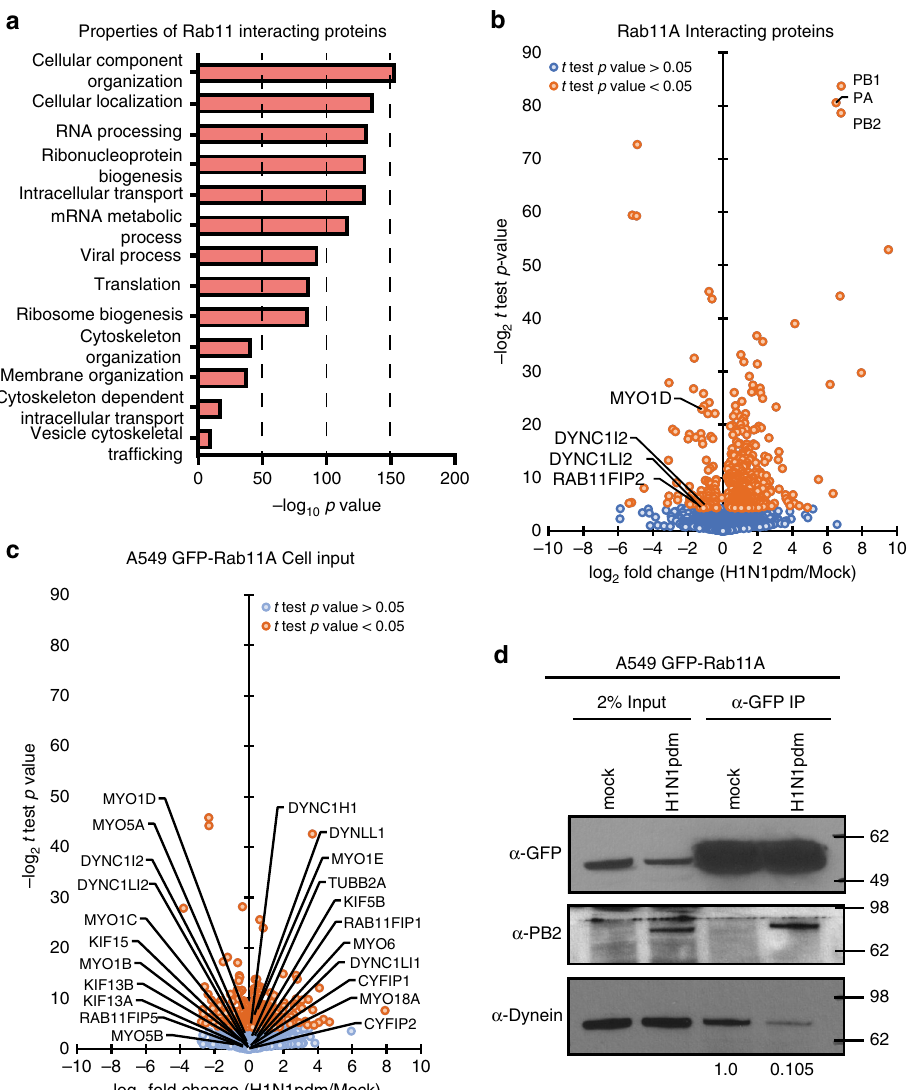
Fig. 7 Rab11A association with dynein motors is decreased during IAV infection. Mass spectrometry of immunoprecipitation (IP) input or α -GFP IP from A549 GFP-Rab11A cells either uninfected or infected with H1N1pdm. a Gene Ontology analysis of Rab11A-interacting cellular proteins revealed by immunoprecipitation – mass spectrometry. b Change in Rab11A-interacting proteins as a ratio of infected to mock cells. Vesicle transport-related proteins signi fi cantly altered during infection and viral polymerase proteins are highlighted. c Ratio of host proteins in IP input as a ratio of infected to mock cells. d Validation and quanti fi cation of dynein levels bound to Rab11A in mock or H1N1pdm-infected cells. Relative band intensity of dynein is noted below the western blot and molecular weight size markers indicated to the right. Source data are provided as a Source Data fi